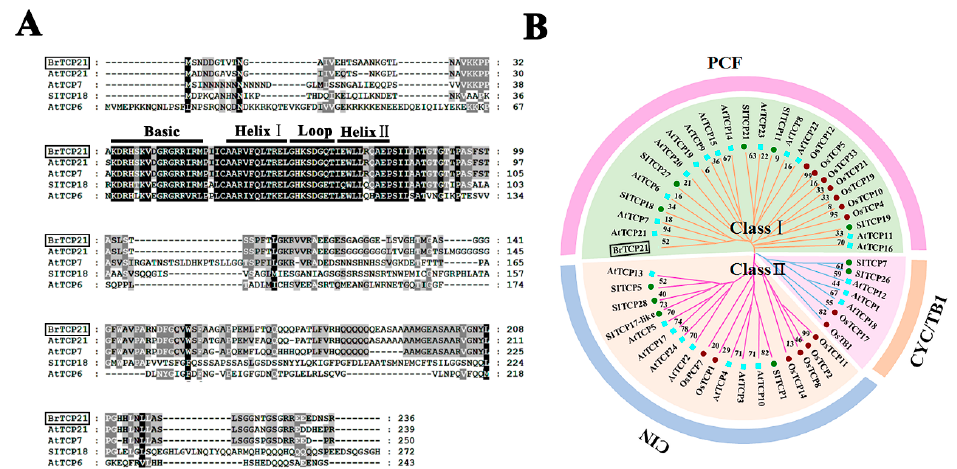
Figure 2. Multiple sequence alignment and phylogenetic analysis of BrTCP21. ( A ) Multiple alignment of BrTCP21 with other TEOSINTE BRANCHED1/CYCLOIDEA/PCF (TCP) members. The following proteins were used for analysis: AtTCP21 (NP_196450.1), AtTCP6 (XP_002870658.2),